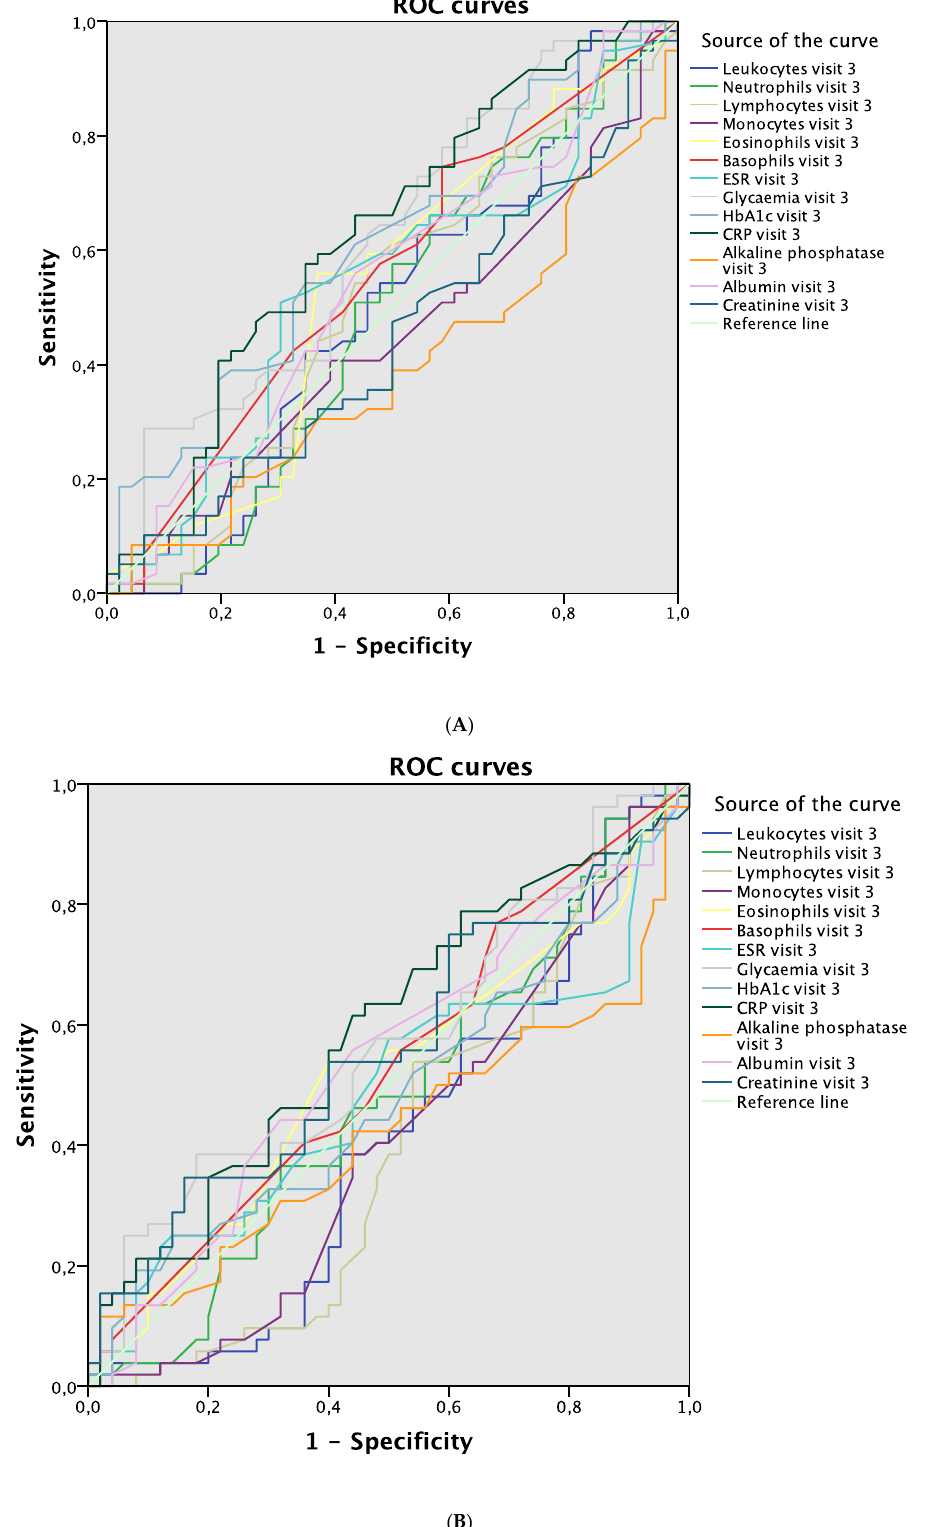
Figure 4. ROC curves. ( A ) Blood parameters in visit 3 associated with complications in visit 3. ( B ) Blood parameters in visit 3 associated with complications in visit 4. Abbreviations: ROC, receiver operating curve; ESR, erythrocyte sedimentation rate; HbA1c, glycosylated hemoglobin; CRP, C-reactive